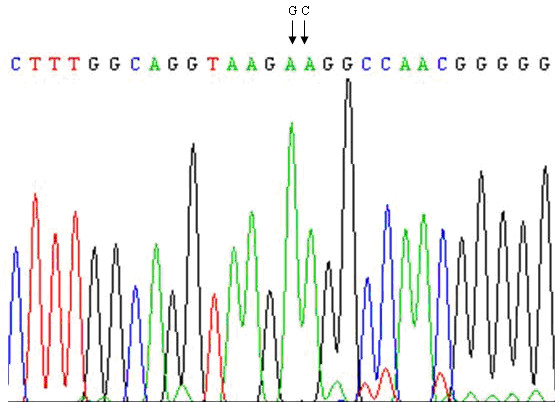
Chromatograph of DGAT1 gene indicating AA → GC (K232A) mutation in Exon8.